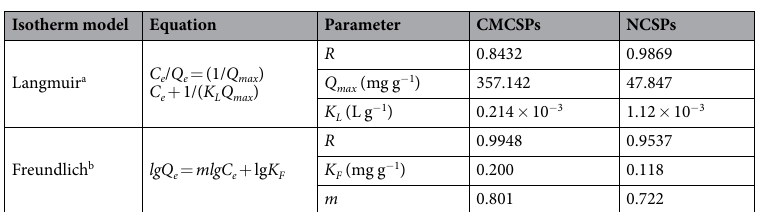
Isotherm model Equation